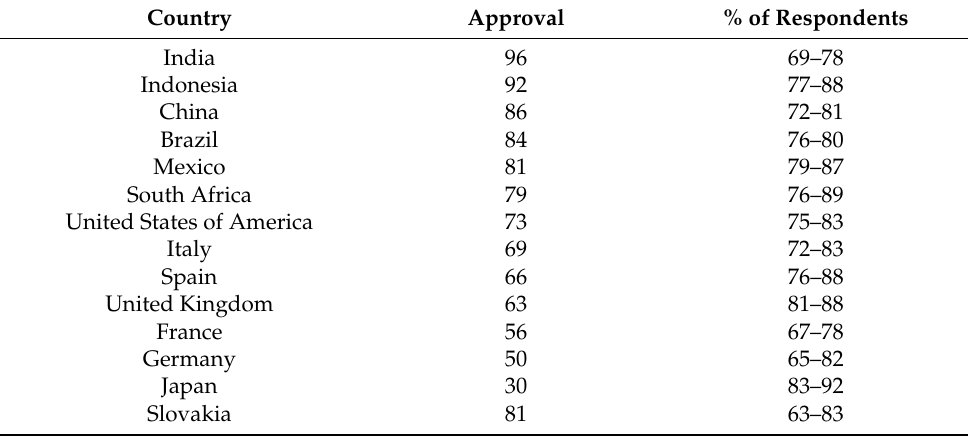
Table 6. Comparison of maintenance of shopping habits in the post-pandemic era.